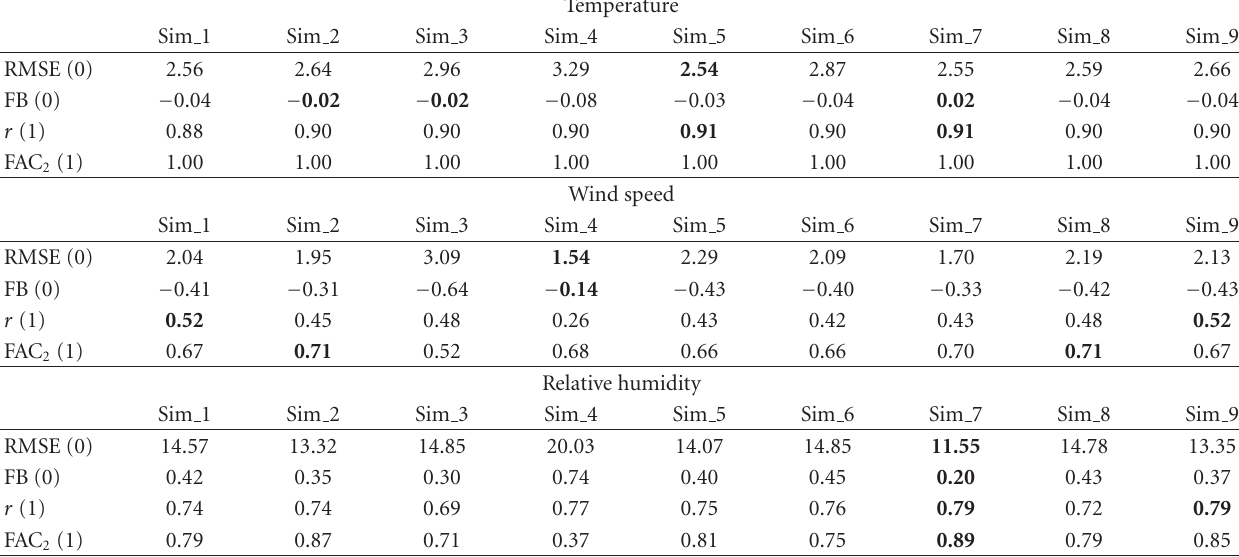
Table 2: Statistical evaluation of summer simulations, station